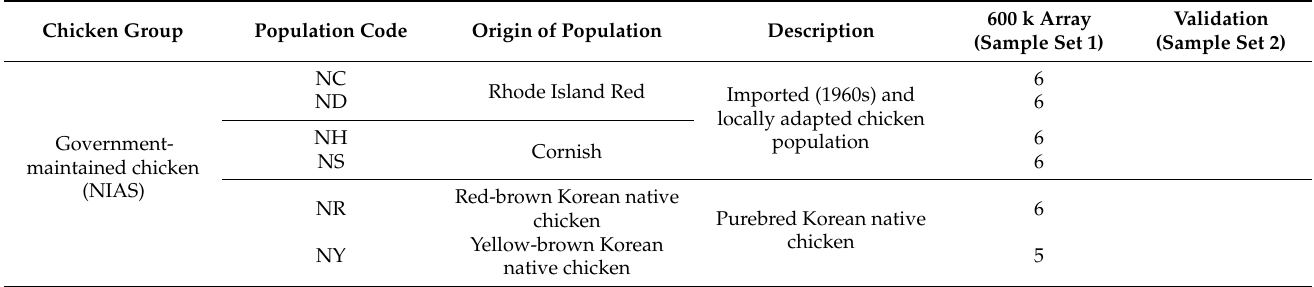
Table 1. Details of the samples used in this